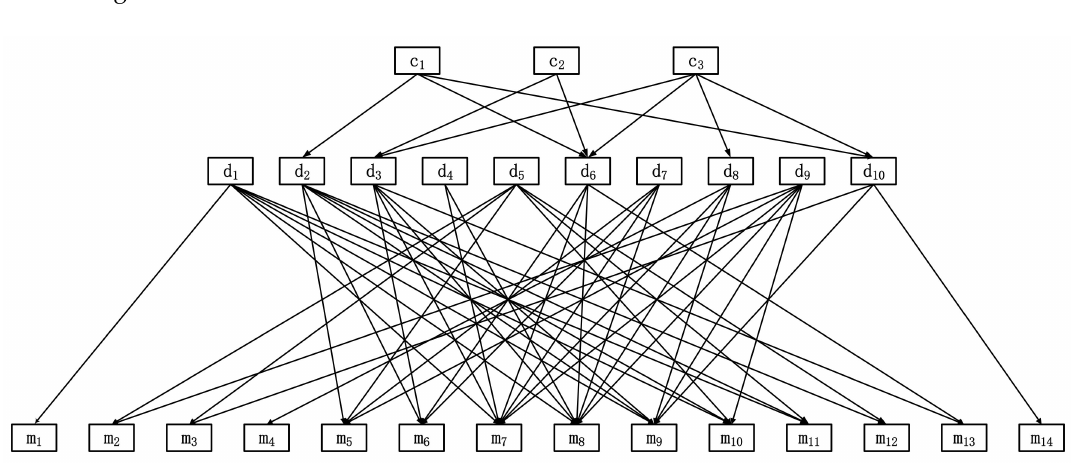
Figure 3. Bayesian diagnosis